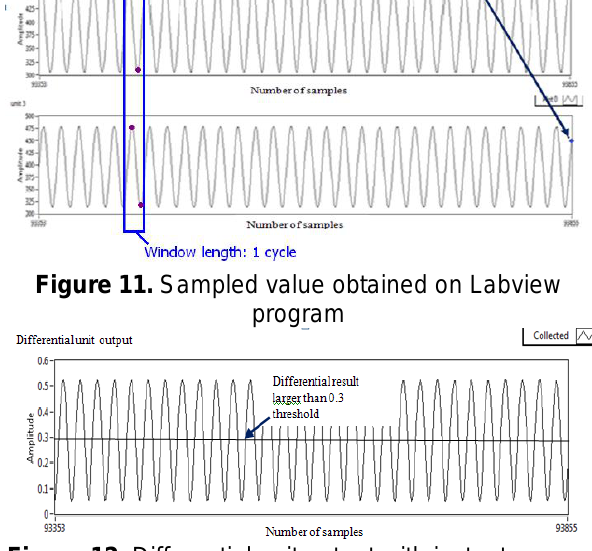
Figure 10. Snapshot of input screen on Labview